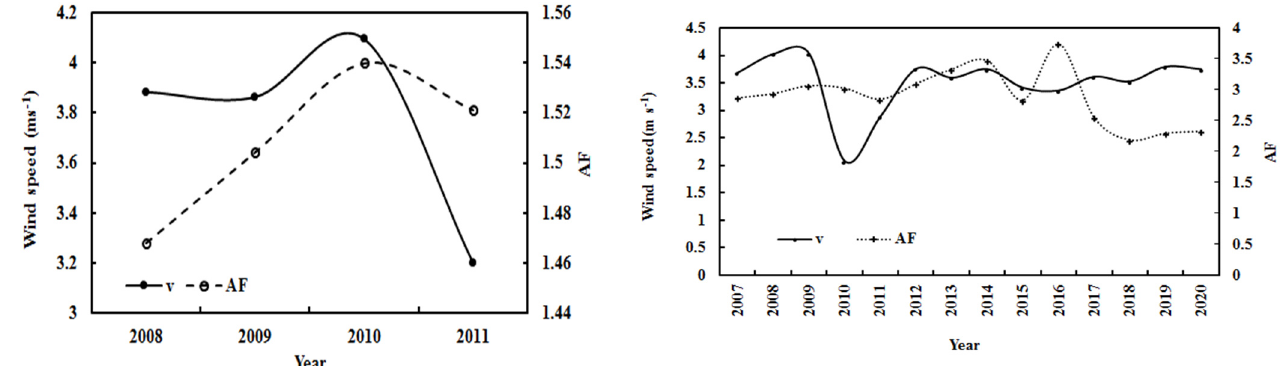
Figure 14. Annual wind speed (v) and atmospheric substances (AF) during 2008–2011 ( left ) and during 2007–2020 ( right ) at the Qomolangma site.